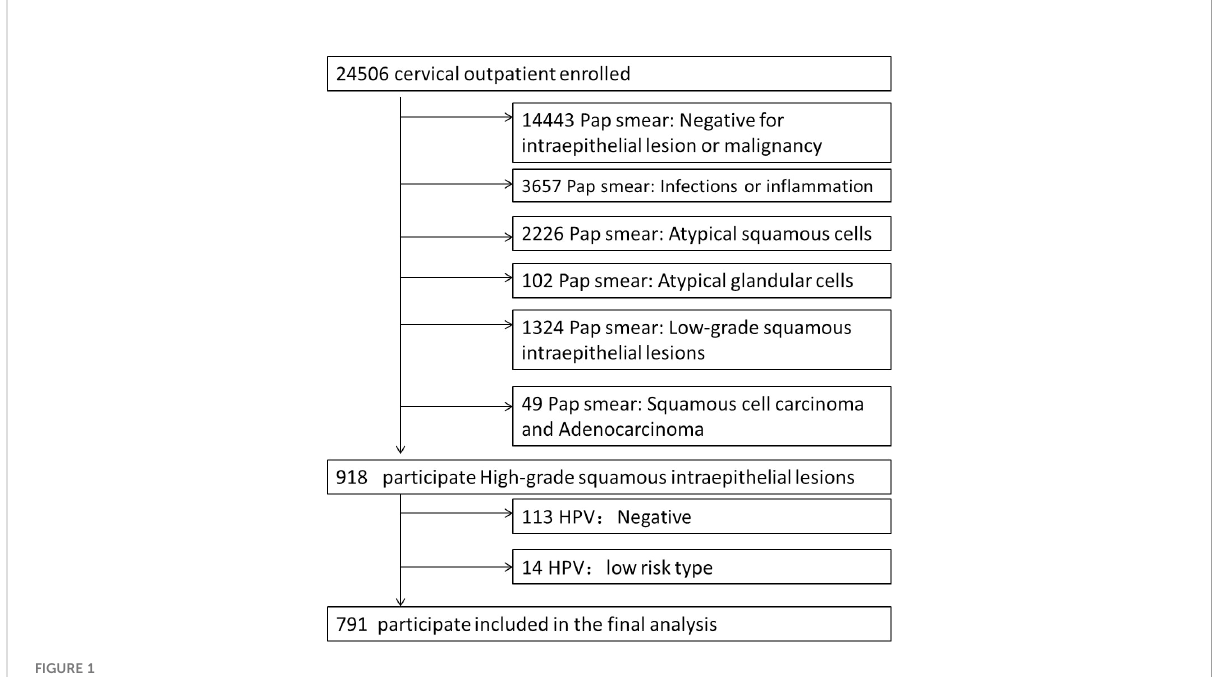
FIGURE 1 Flowchart of